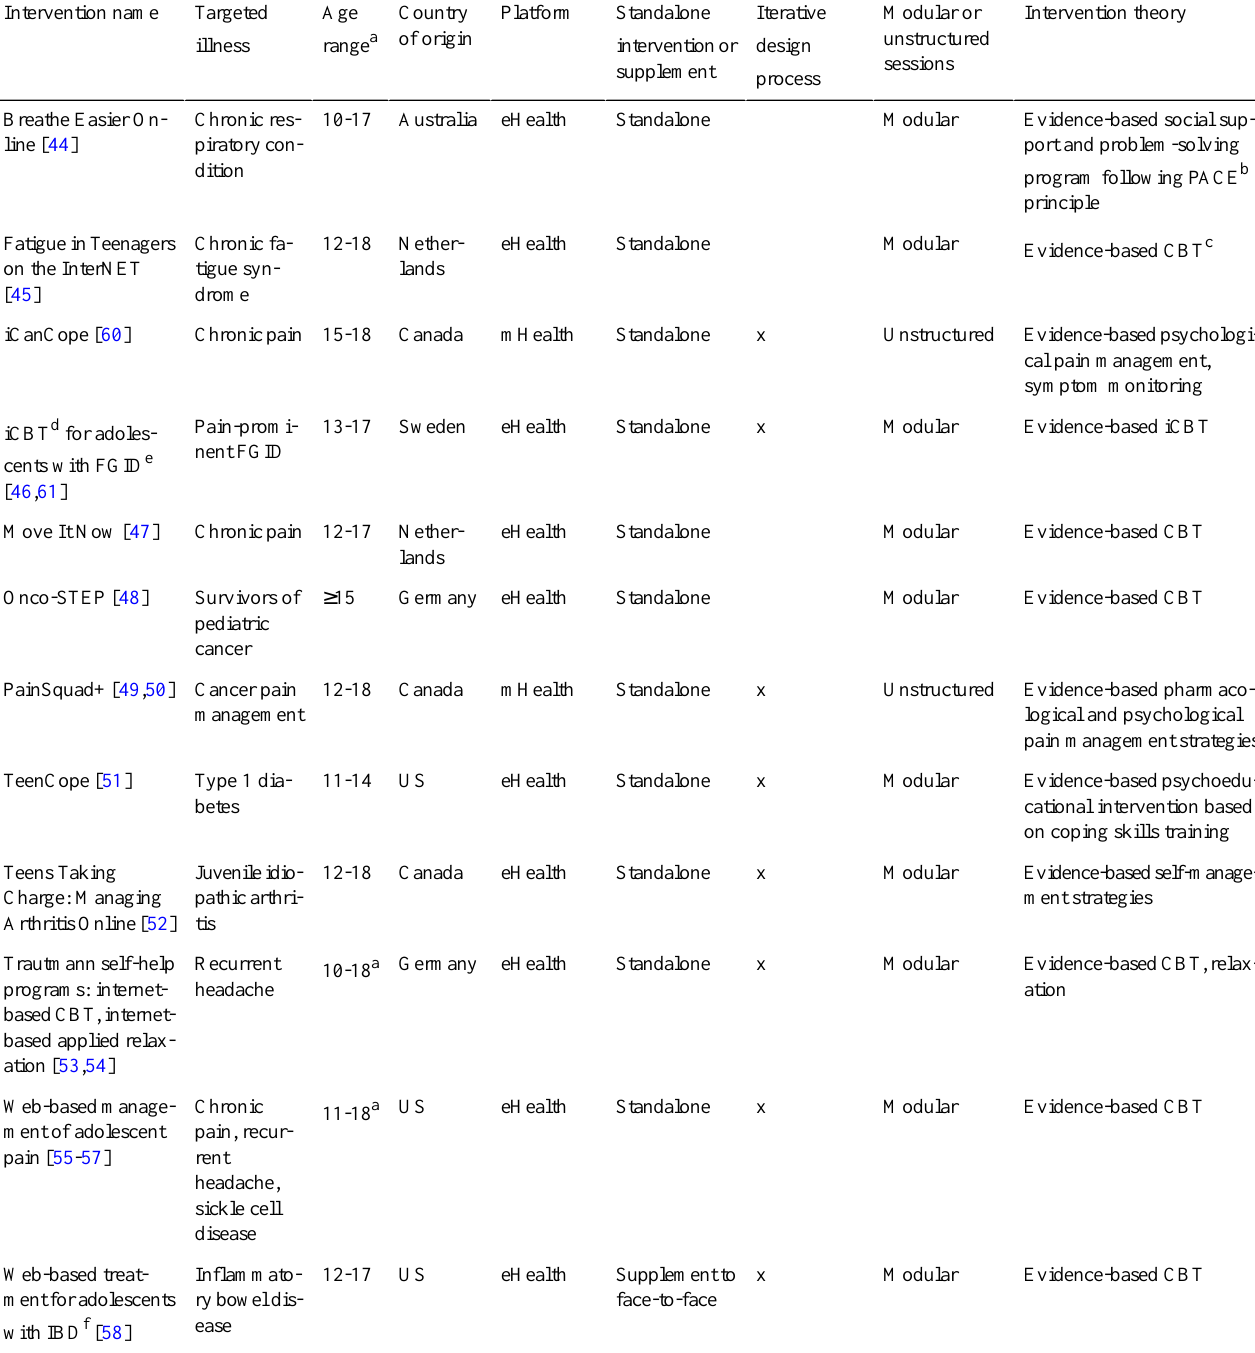
Table 1. Interventions targeted for youth chronic illness